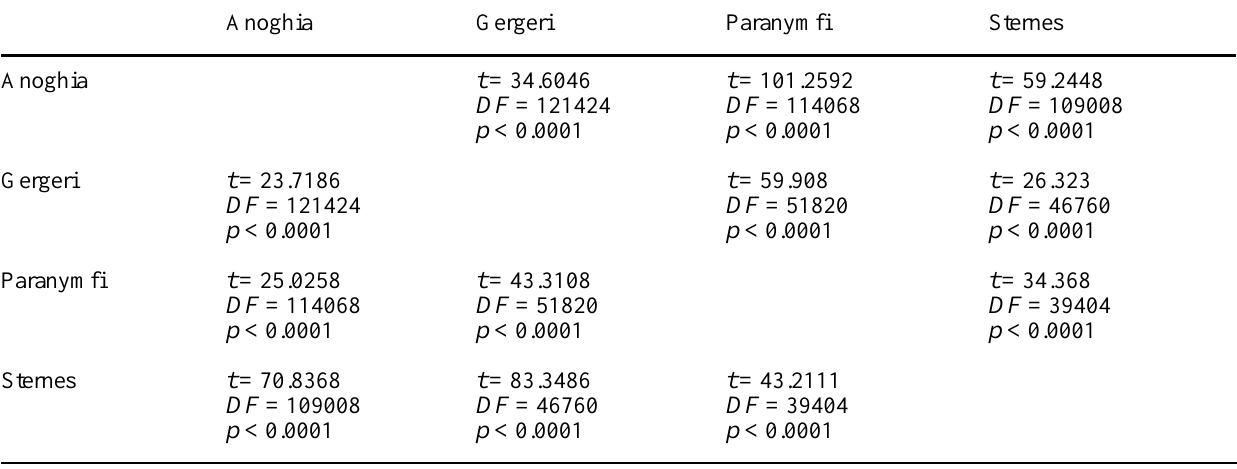
Table 10. Statistical differences in pixel mean vegetation cover and vegetation-cover trend between the rangeland areas of the four village communities. Values in cells located in the upper right of the diagonal refer to t -tests run on vegetation-cover trend; values in the lower left refer to t -tests run on mean vegetation- cover values ( t = t -value; DF = degrees of freedom, p = p